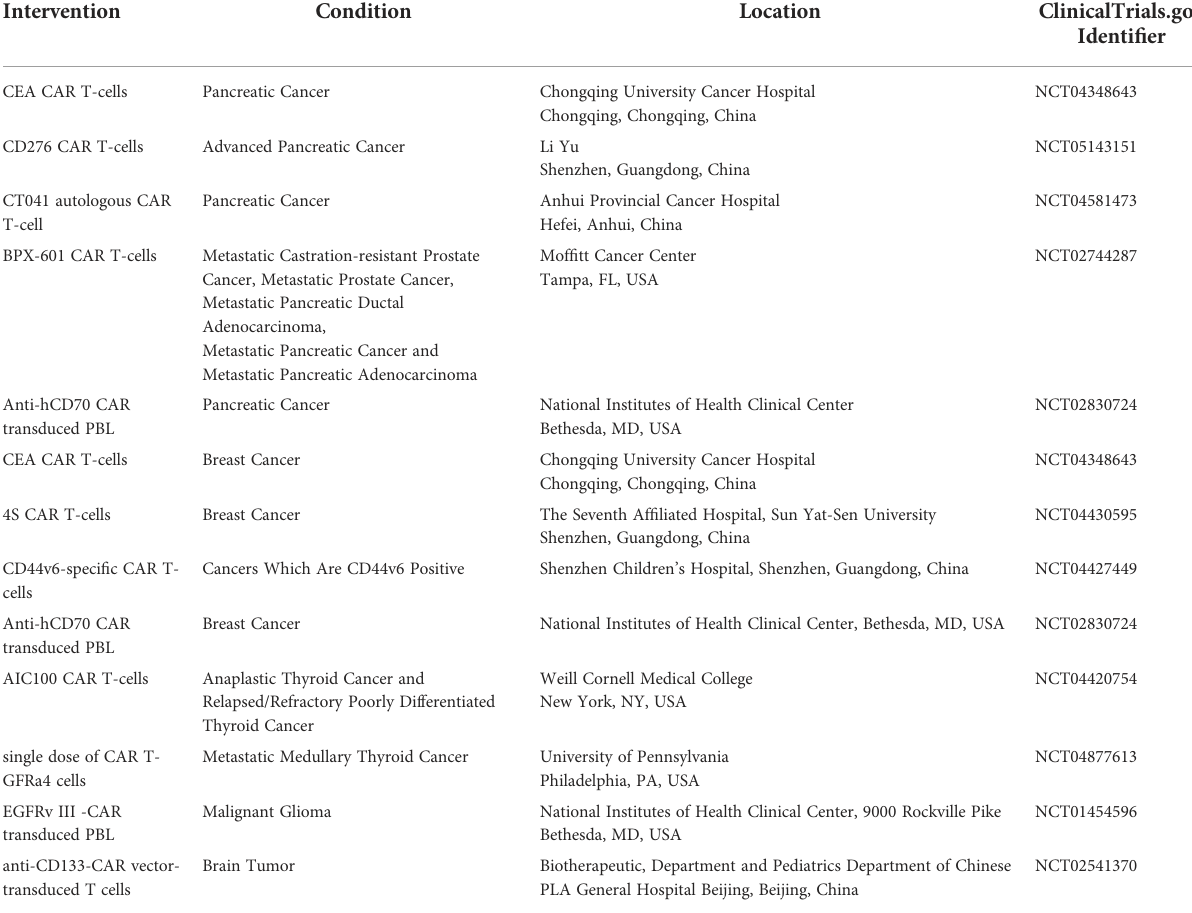
TABLE 1 Ongoing and currently recruiting clinical trials involving CAR T-cell therapies for solid tumors (22).